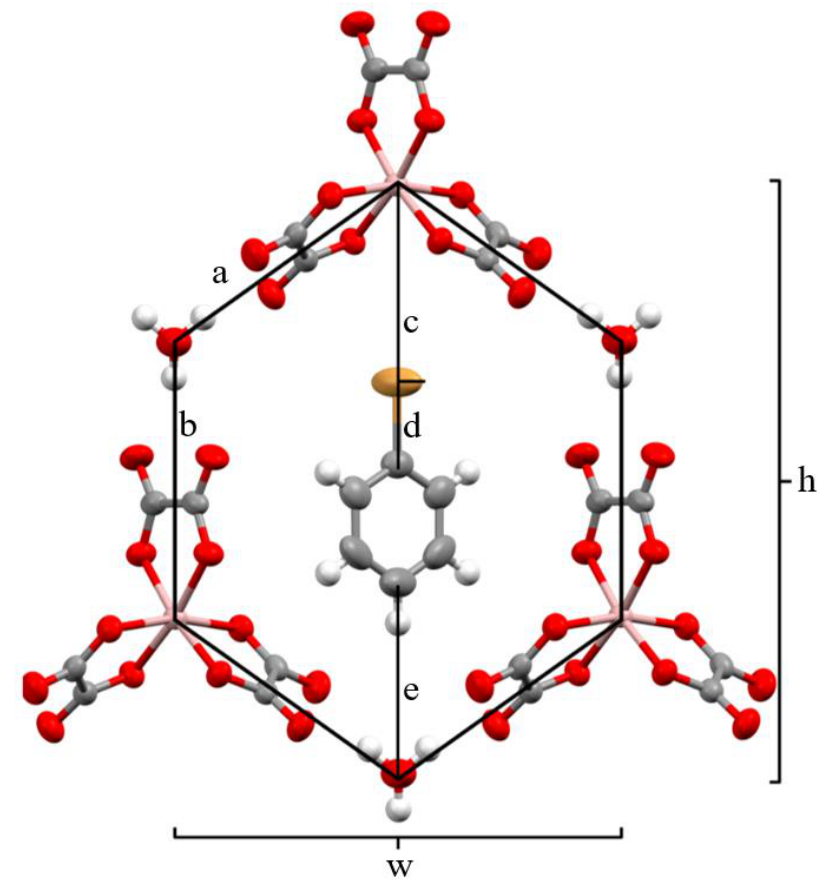
Figure 3. Honeycomb cavity in the anion layer of β″-(BEDT-TTF) 4 (H 3 O) M (C 2 O 4 ) 3 · G salts with measurement parameters labelled ( a – e , w = width, h = height). Carbon atoms are grey, hydrogen atoms white, and oxygen atoms red. This image shows salt Al-PhBr , where aluminium atoms are pink and bromine atoms brown.